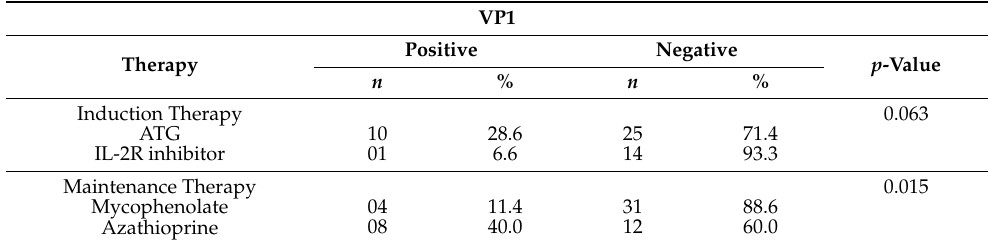
Table 4. Prevalence of polyomavirus in transplanted patients according to the type of immunosup- pression therapy, at Ophir Loyola Hospital, Bel é m, Par á , Brazil,